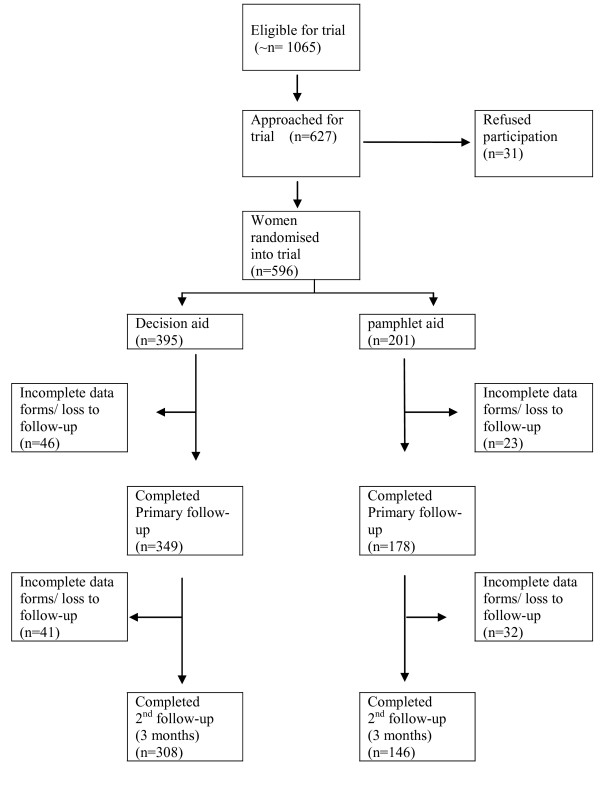
Flow of participants through trial.